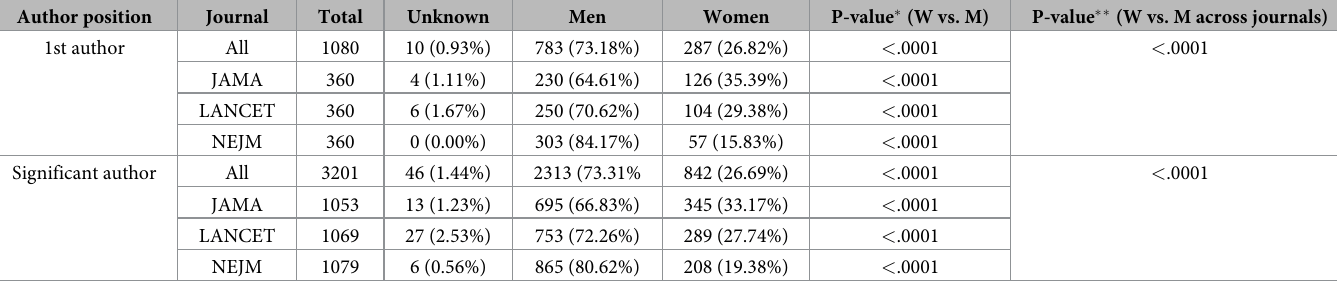
Table 1. Top medical research journals’ publications by gender classified by author